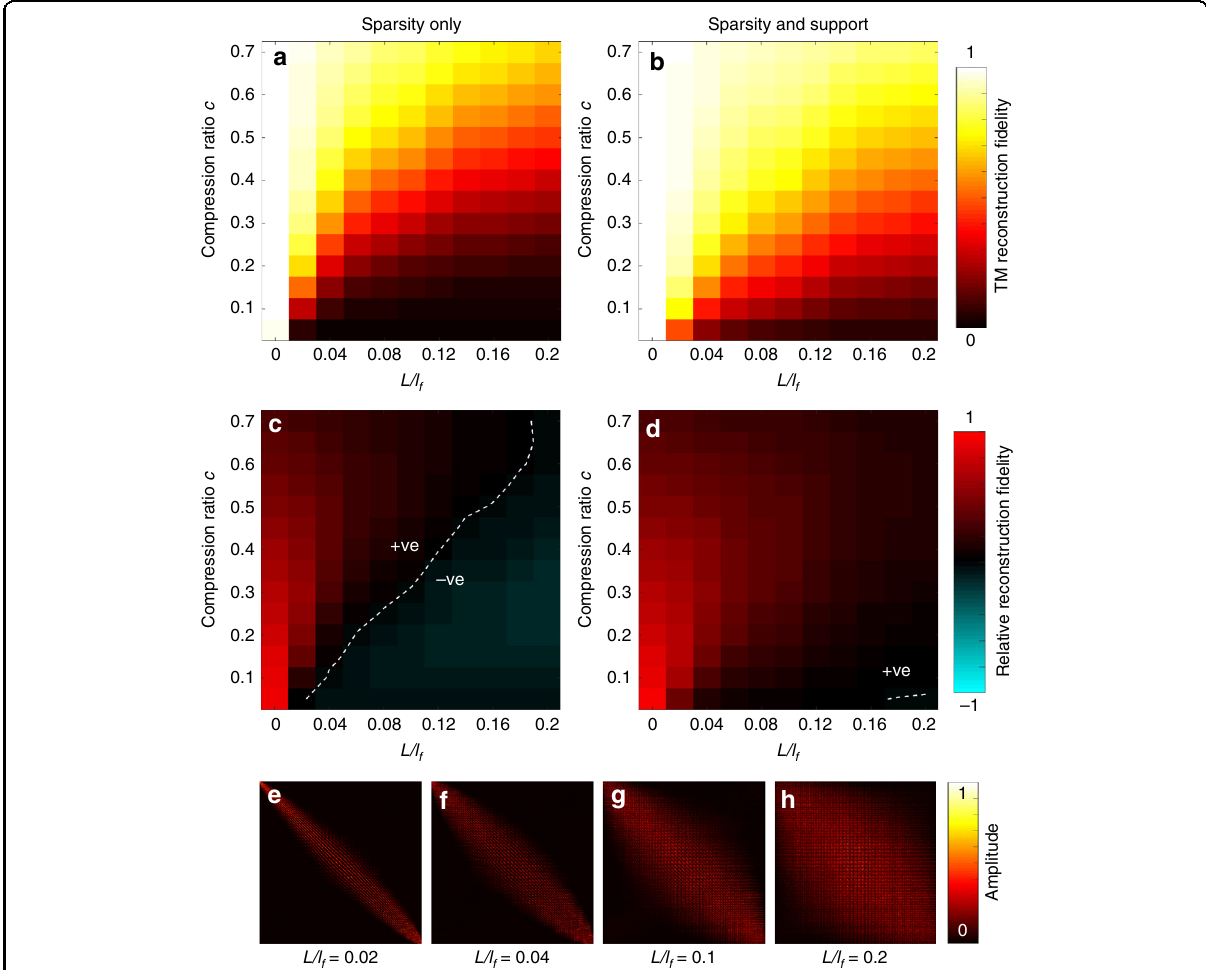
Fig. 5 Simulated performance of compressive TM measurement for increasing levels of modal coupling. a A heat map showing the normalised TM reconstruction fi delity, when using a sparsity prior only, as a function of the degree of modal coupling ( L / l f ) and the compression ratio c . b Normalised TM reconstruction fi delity using sparsity and support priors. c The TM reconstruction fi delity depicted in ( a ) relative to the fi delity achievable using the columnwise method (which has a fi delity of c ), i.e. the normalised TM reconstruction fi delity minus c . In the positive region, FISTA outperforms the columnwise method. In the negative region, the columnwise method outperforms FISTA. The white line represents the dividing line between the two regions. d The TM reconstruction fi delity shown in ( b ) relative to the columnwise method. e – h Examples of the absolute values of simulated TMs showing the tested range of modal coupling. e corresponds to a level of modal coupling similar to that observed in our